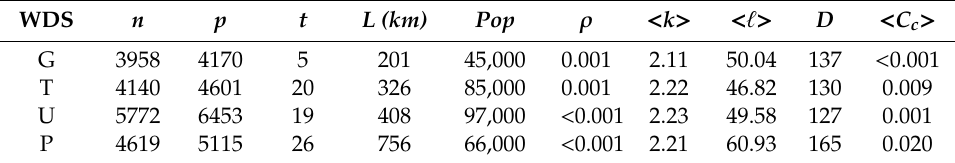
Table 1. Main characteristics of the real WDSs analyzed: n , number of junctions; p , number of pipes; t